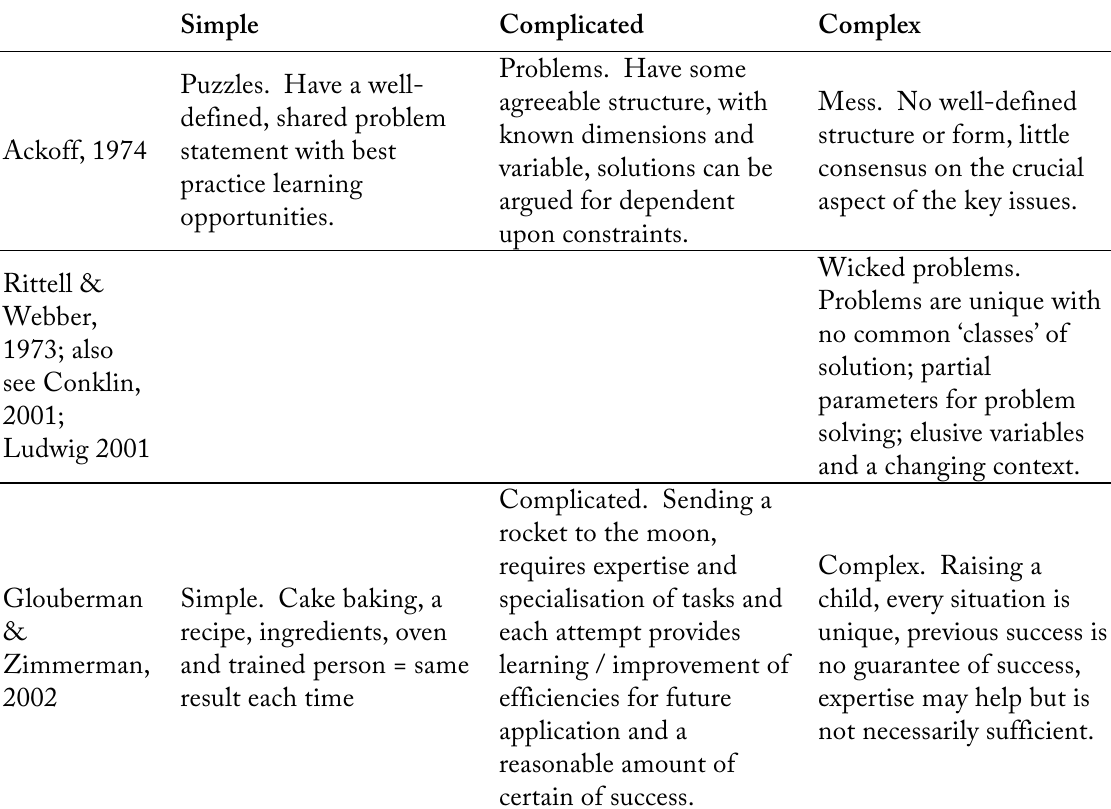
Table ii: Contextualising the challenge. Source : adapted from Jones (2011:4) One prominent management tool that attempts to explicitly challenge this bottle-neck is the Cynefin Framework below, Figure ii, (Boone & Snowden,